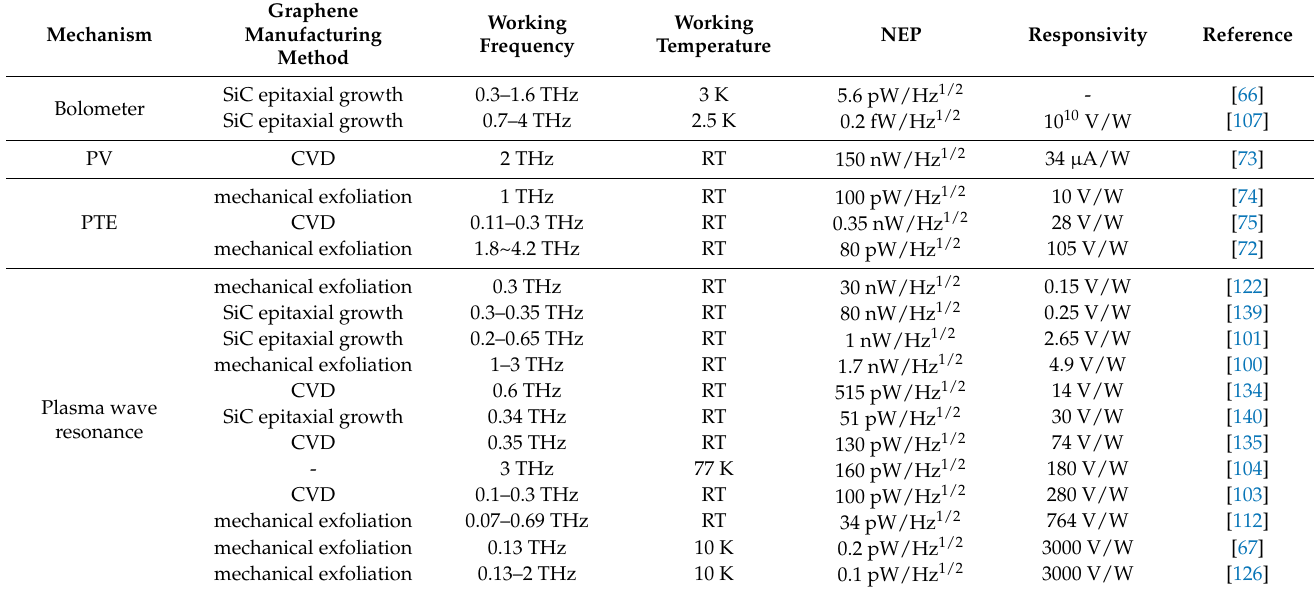
Table 2. Performance parameters of graphene terahertz detectors mentioned in the